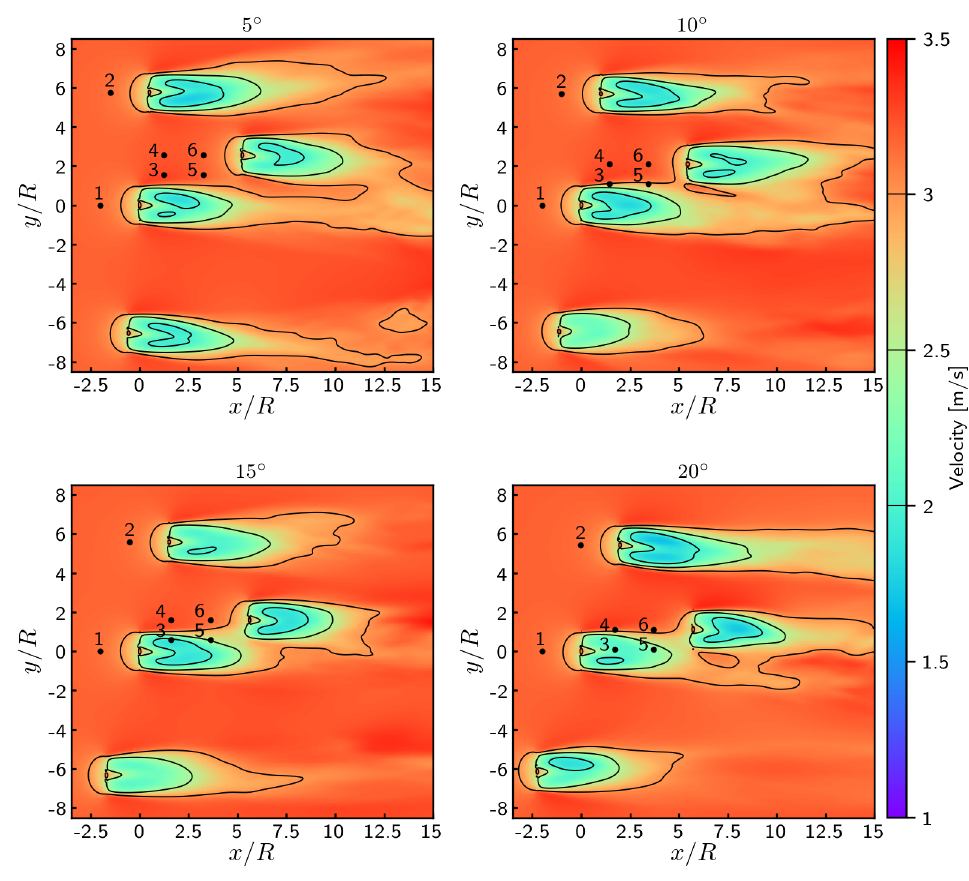
Figure 14. Time-averaged wakes obtained for several yaw angles ( I ∞ = 10%, L = 18 m, Rf ≈ 229, TSR = 4.1, σ ( λ ) =